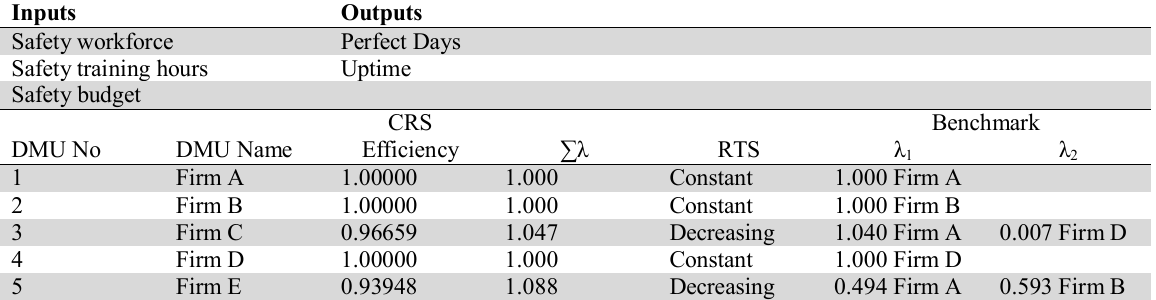
Result of the CRS Input-oriented model